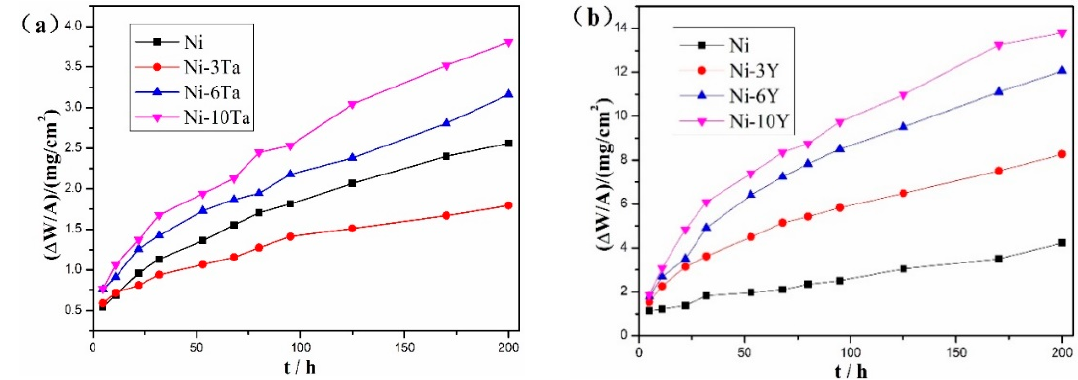
Figure 3. The mass gain of Ni ‐ based alloys as a function of oxidation time at 800 °C: ( a ) Ni ‐ (3~10) Ta alloys and ( b ) Ni ‐ (3~10) Y alloys.